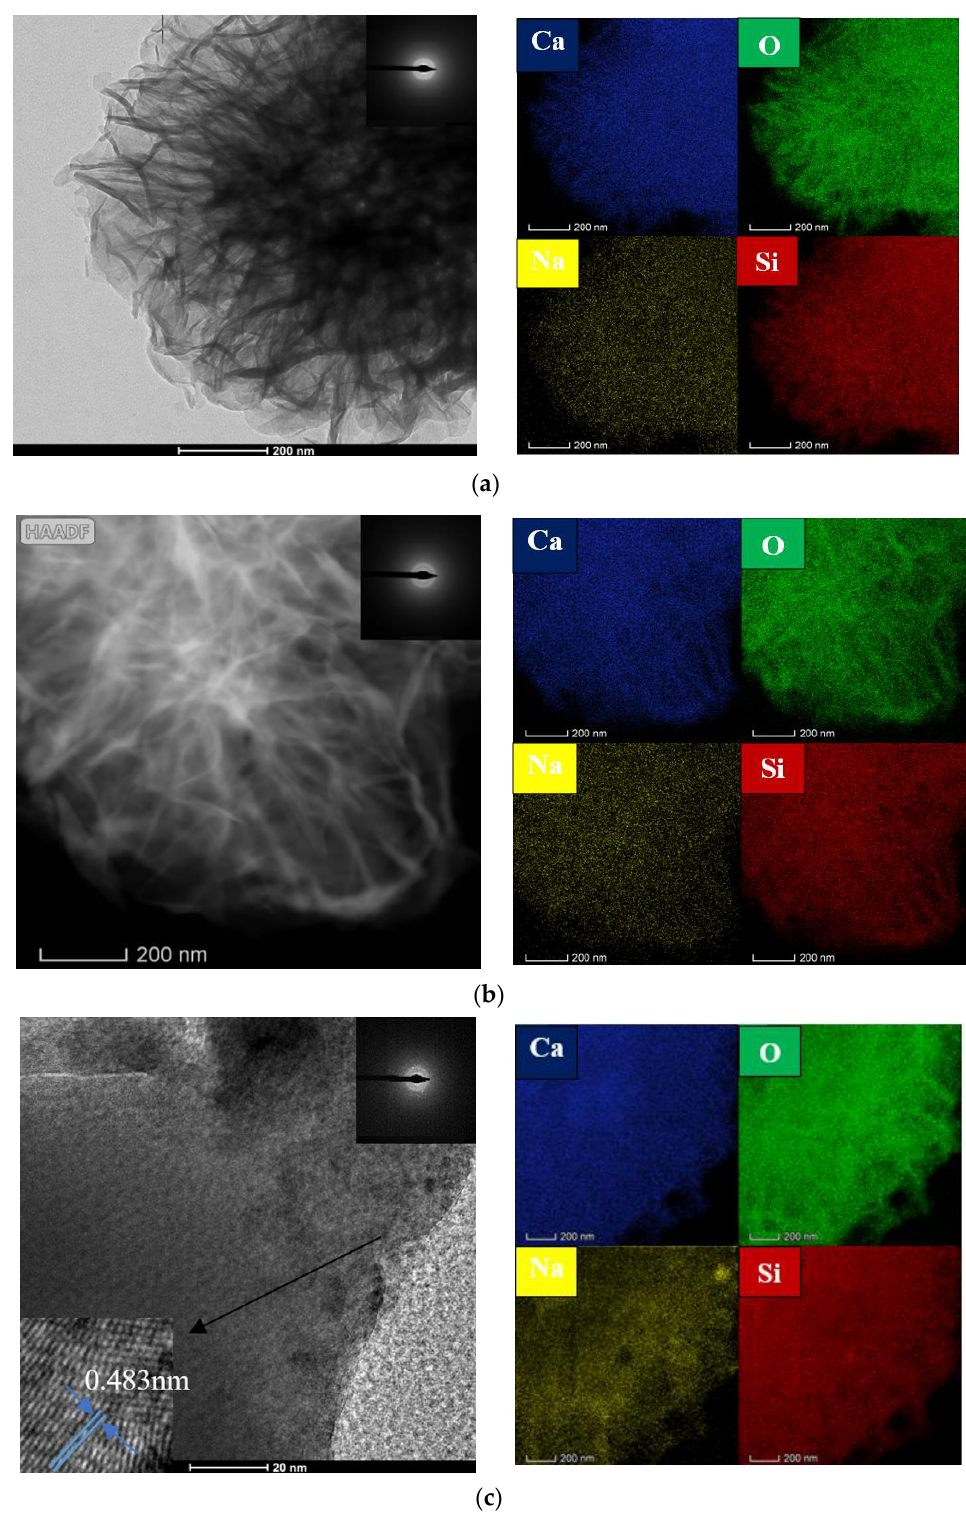
Figure 5. TEM of products at different temperatures: ( a ) 295 K; ( b ) 310 K; ( c ) 330 K.